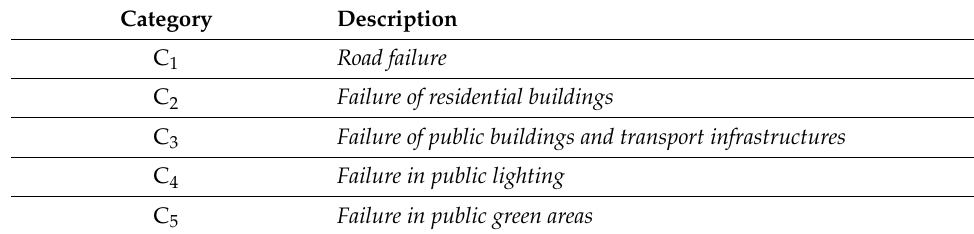
Table 4. Set of categories of